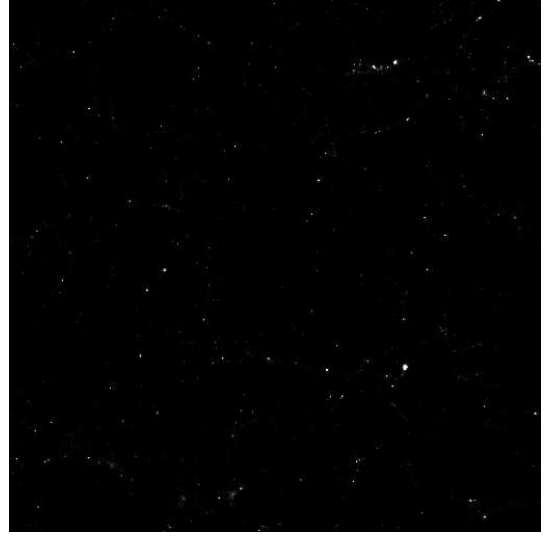
Figure 3. The same slice of Figure 2 but cut off at ̺ = 256 . Notice the